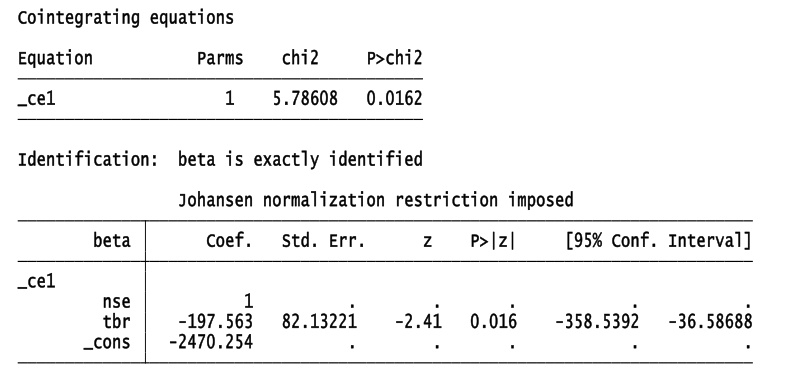
Source: Study data (2007 – 2016)